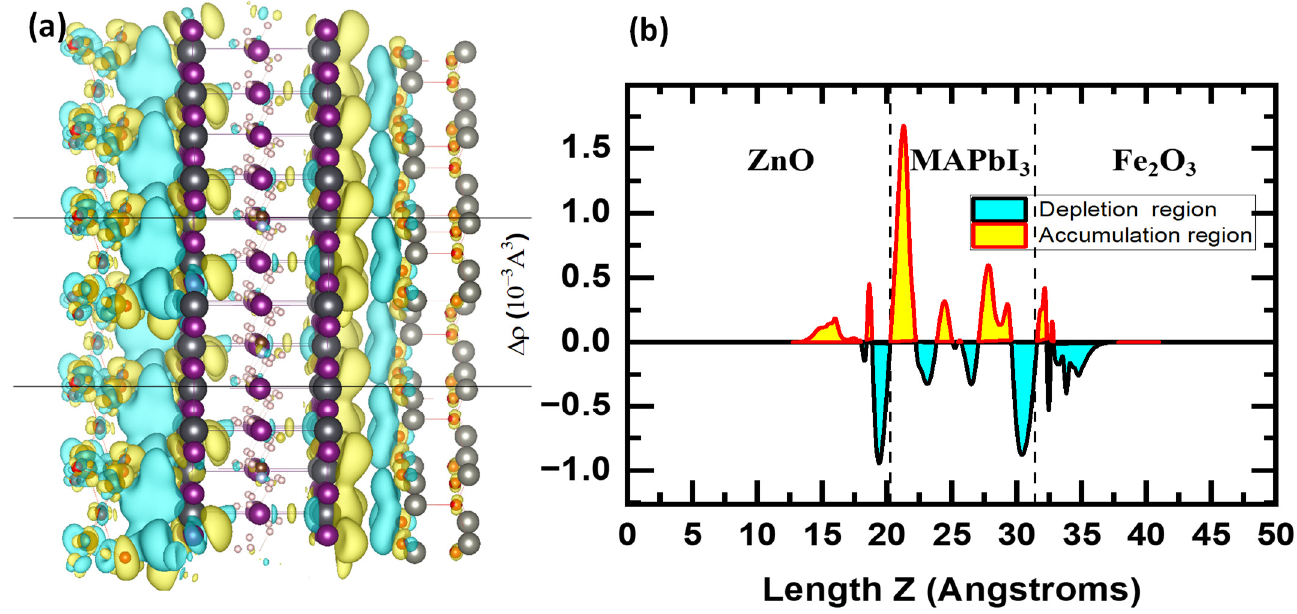
Figure 4 . 3D charge density difference for ( a ) ZnO:Al/MAPbI 3 and MAPbI 3 /Fe 2 O 3 , ( b ) Planar-averaged electron density difference ∆ρ (z) for Fe 2 O 3 /MAPbI 3 /ZnO .